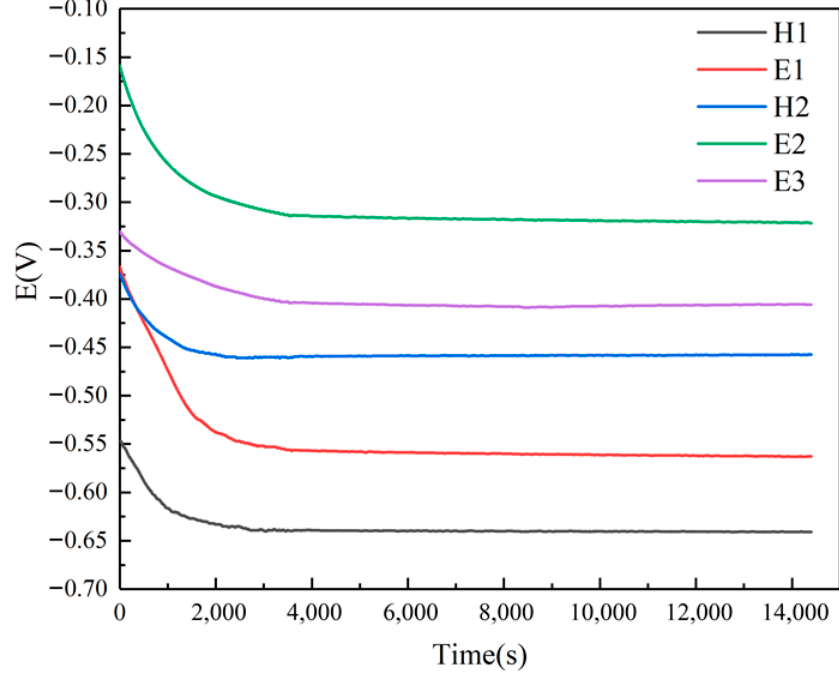
Figure 8. OCP curves. Table 5. Electrochemical results of OCP and potentiodynamic